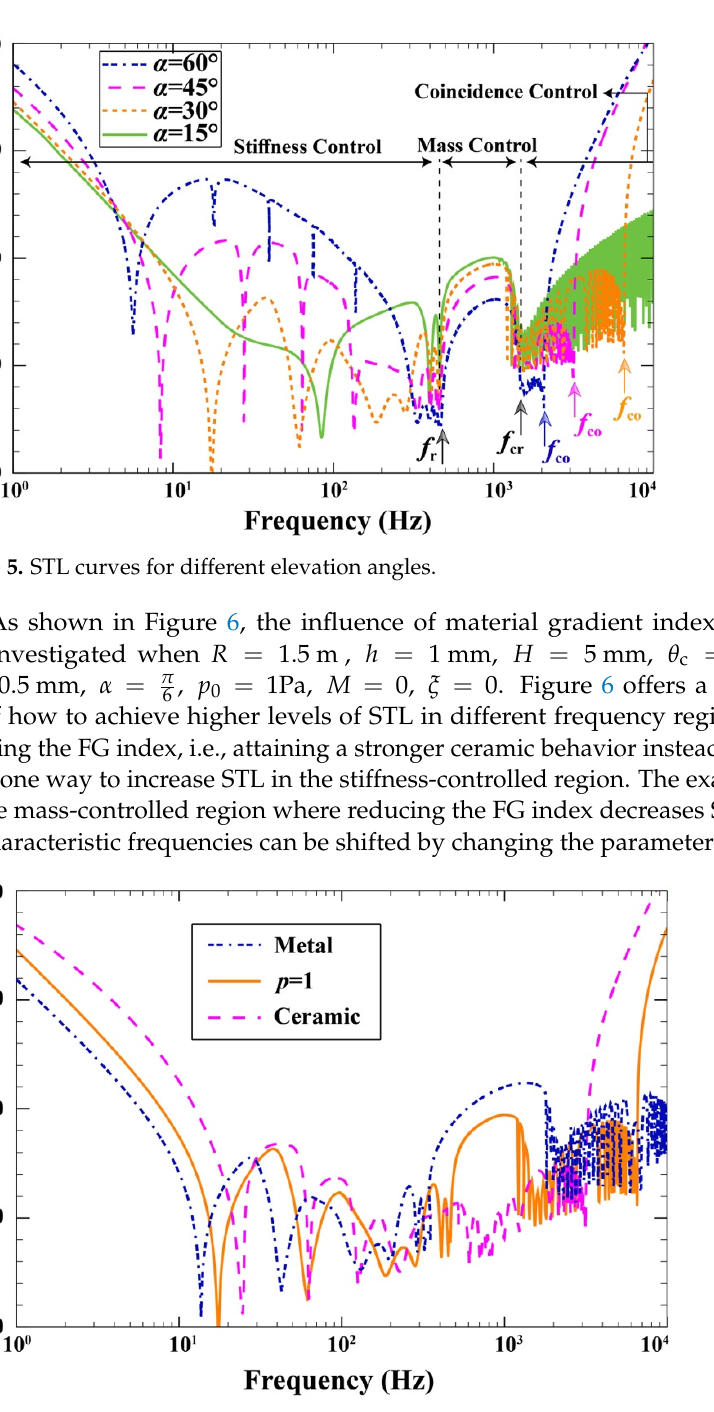
Figure 6. Variation of STL through the honeycomb FGP sandwich cylindrical shell with material gradient index.